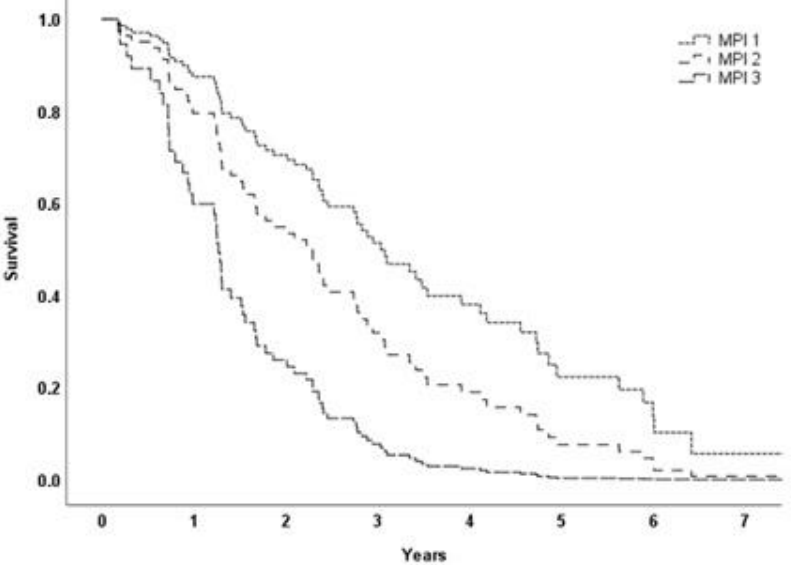
Figure 2. Cox regression survival curve stratified by MPI groups. Model adjusted for age and